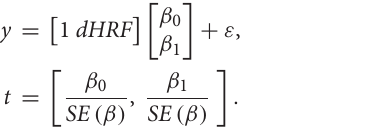
1.9632). The critical t -value was computed by the degree of freedom of the signals and statistical significance ( p < 0.05 for two-sided